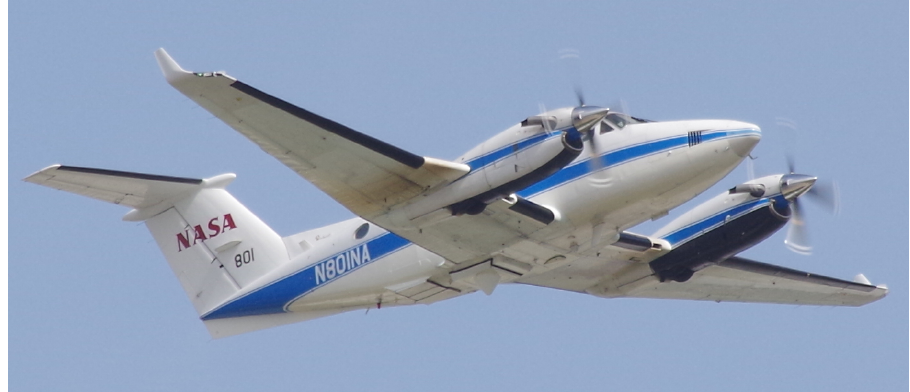
Figure 3. View of the NASA-801 King Air B200 with the DopplerScatt radome mounted on the underside.